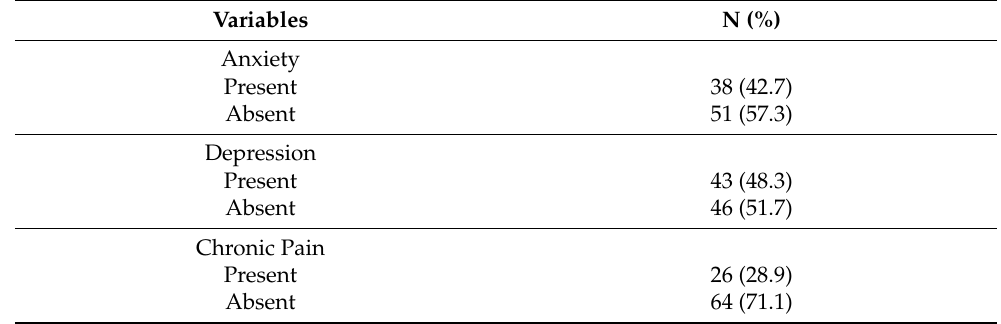
Table 2. Main outcomes frequencies.